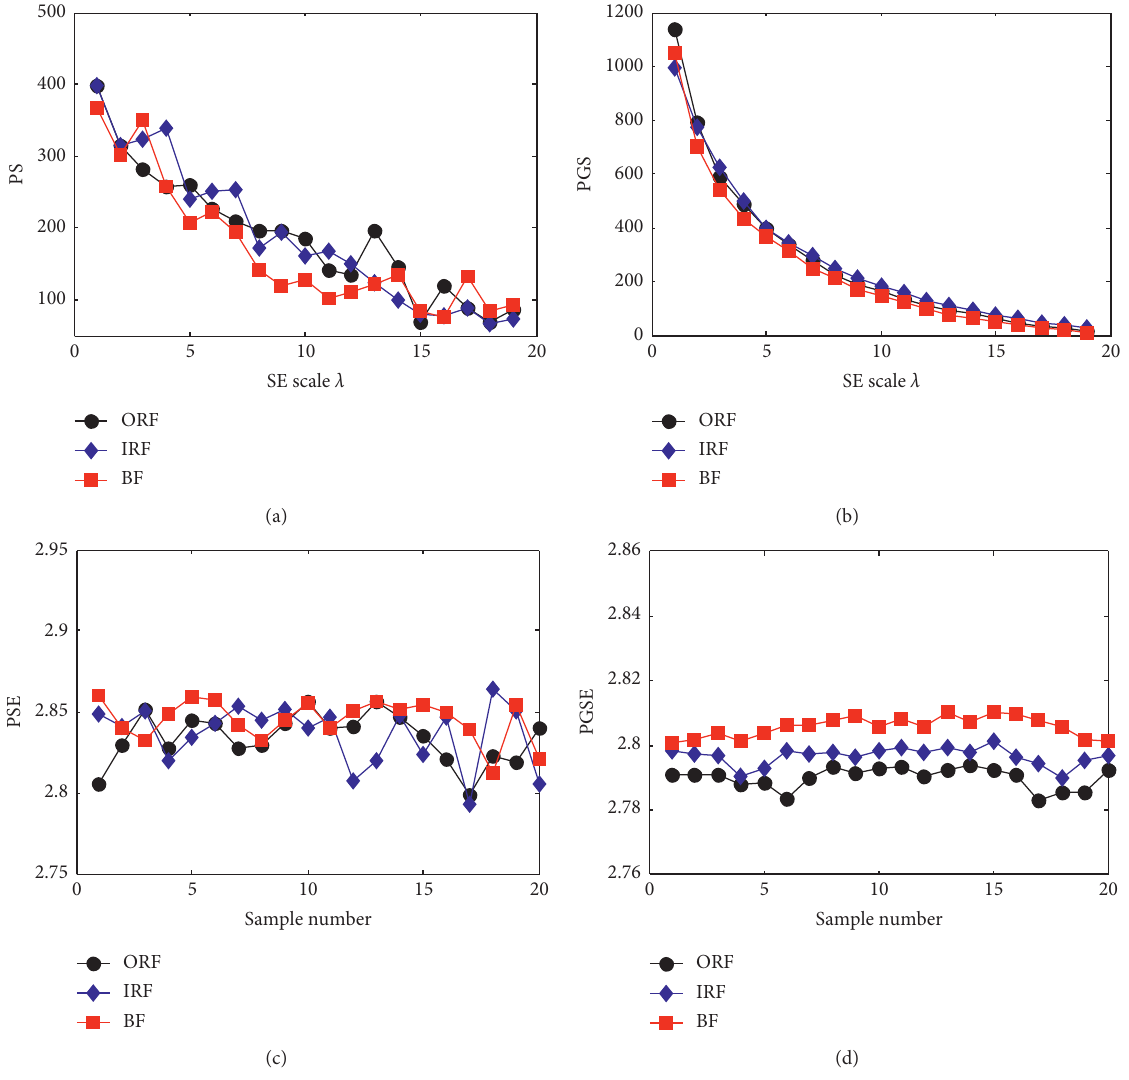
Figure 3: The analysis results of different simulation signals under pink noise: (a) PS, (b) PGS, (c) PSE, and (d) PGSE. Table 1: CPU running time of different methods under white noise and pink